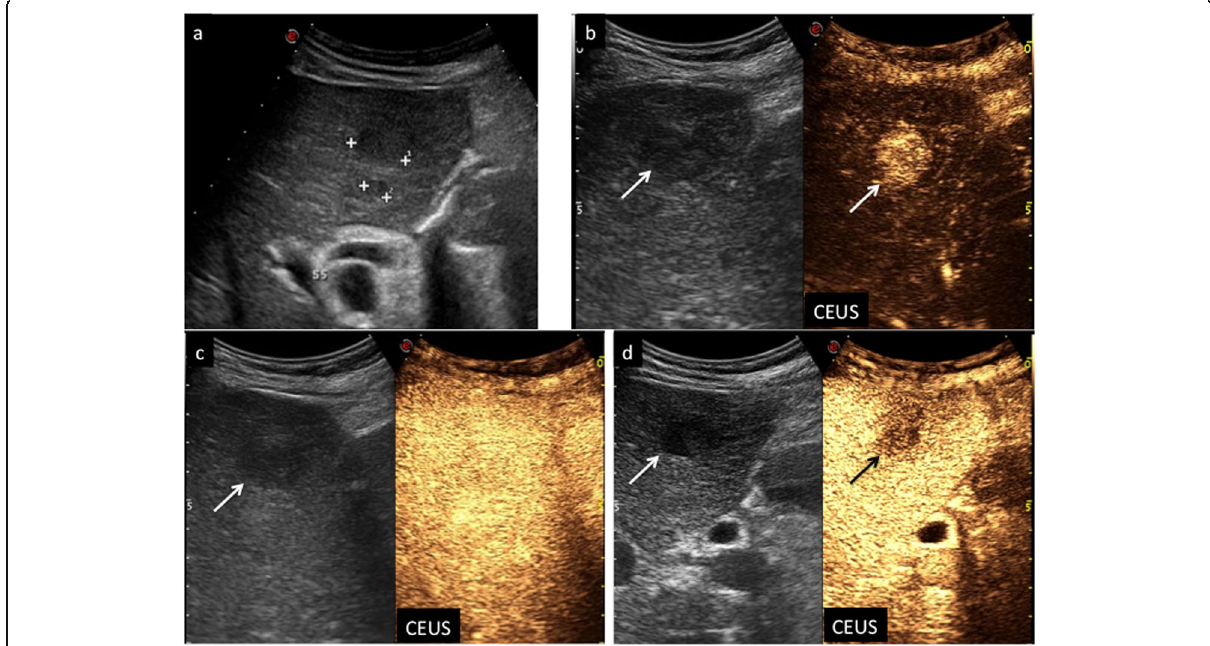
Fig. 9 CEUS LI-RADS 5 (definitely HCC). Nodule in a 72-year-old man with virus B-related cirrhosis. Baseline US image ( a ) shows two moderately hypoechoic lesions sized, respectively, 2.2cm and 0.7cm in the segment V (calipers). At CEUS, the largest one is markedly hypervascular during the arterial phase ( b ) (arrows), becoming isoechoic 45s after contrast medium injection ( c ) (arrow) and showing moderate wash-out 120s after contrast medium injection ( d )